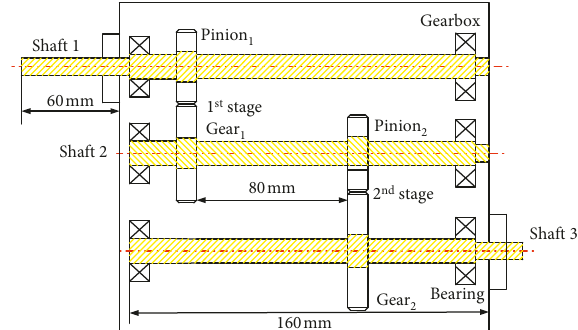
Figure 1: Structural model of two-stage gear transmission system (all dimensions are in